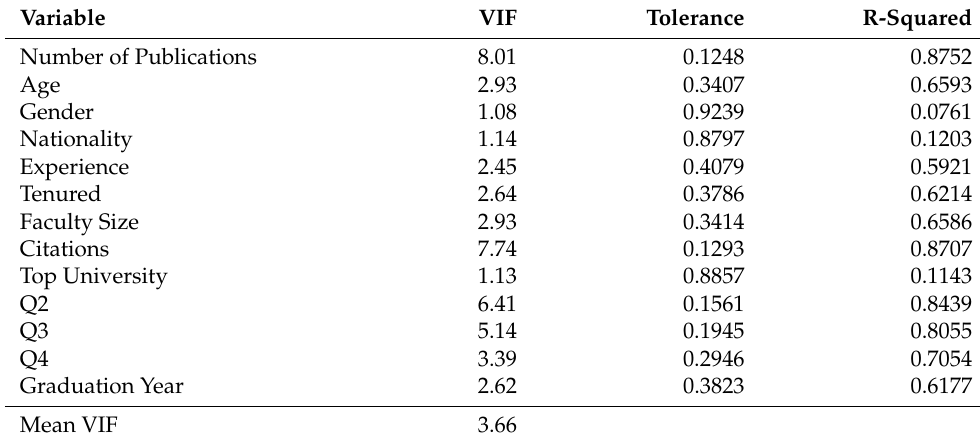
Table 2. Collinearity